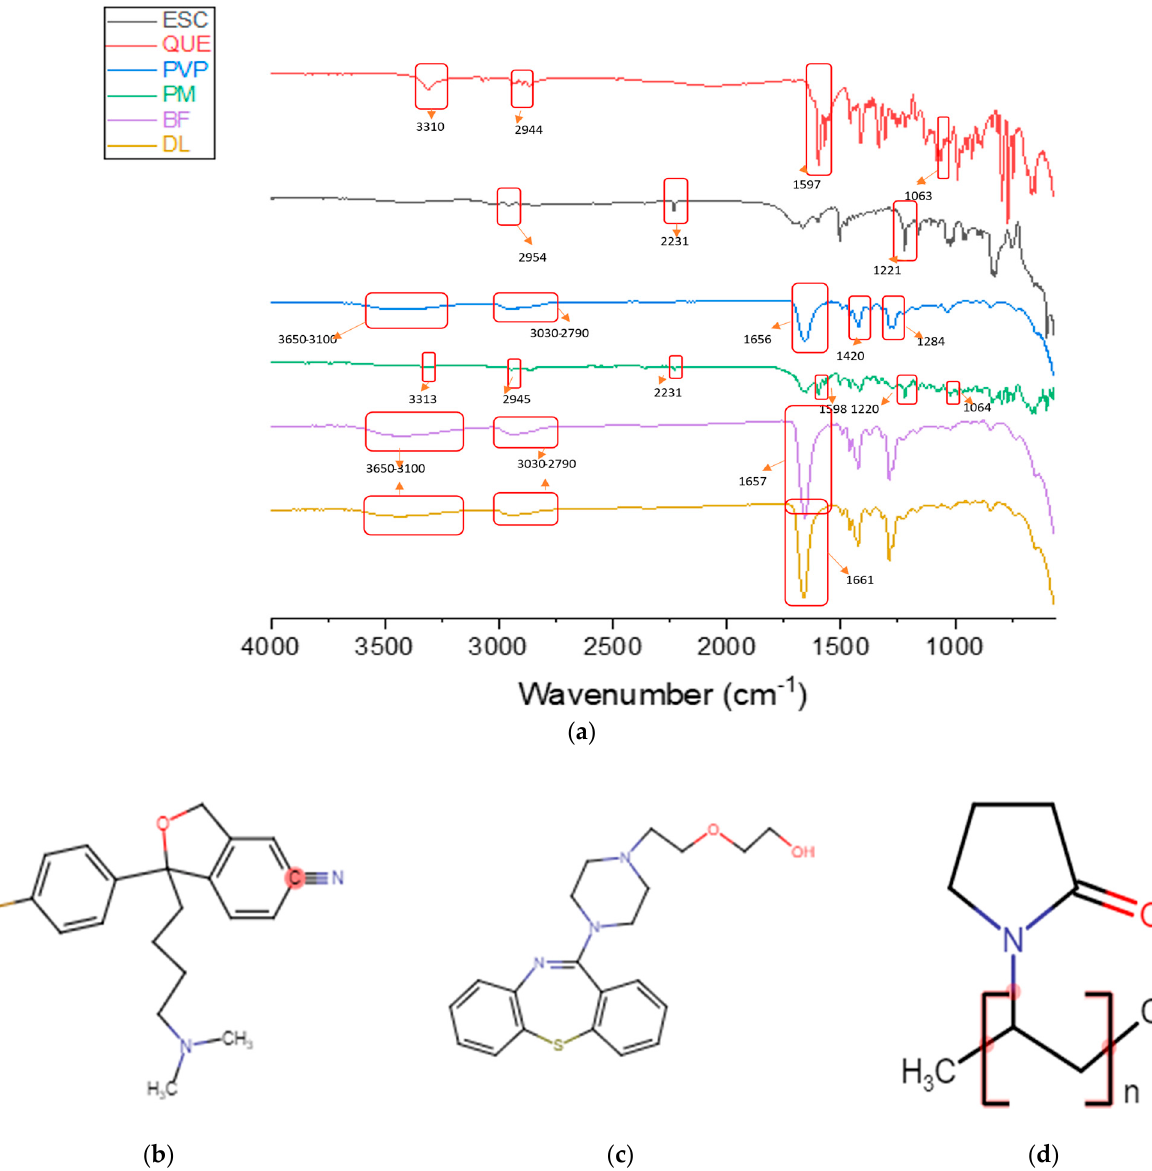
Figure 5. ( a ) FTIR spectra of ESC, QUE, PVP, PM (physical mixture), BF (blank fibers), and DL (drug-loaded fibers), showing each material’s distinctive peaks. Chemical structures of ( b ) ESC, ( c ) QUE, and ( d ) PVP were drawn by chemspace.com.